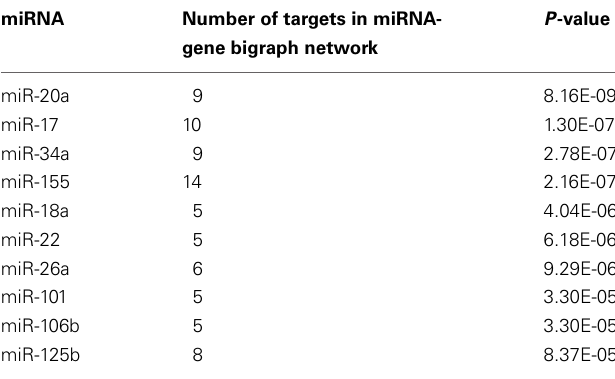
Table 3 | The top ten microRNAs targeting on nodes of genetic sub-network in the brain of SAMP8